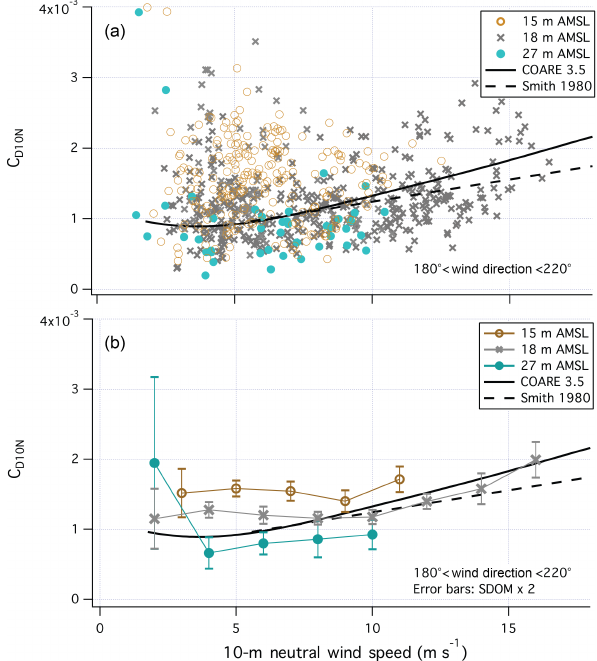
Figure 4. 10m neutral drag coefficient vs. 10m neutral wind speed at sampling heights of 15, 18, and 27ma.m.s.l. (a) 10min EC mea- surements, (b) bin averages, with error bars indicating two standard errors within each wind speed bin. Wind data are from the Wind- master Pro sonic anemometer. Also shown are C D10N parameter- ized from the COARE model version 3.5 (Edson et al., 2013) and Smith